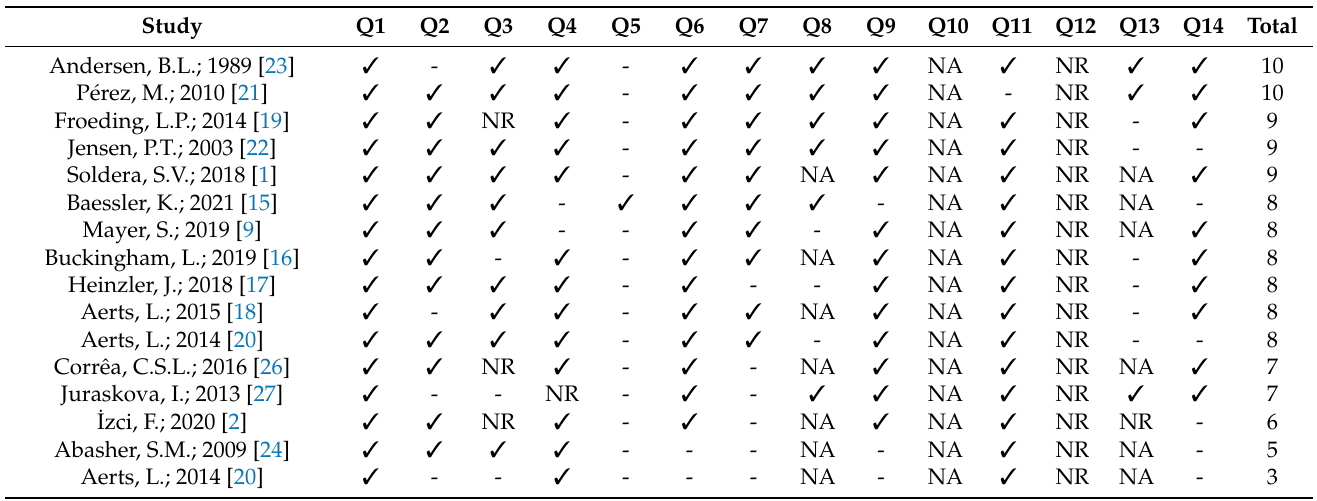
Table 4. Methodological quality assessment according to the Quality Assessment Tool for Observa- tional Cohort and Cross-Sectional